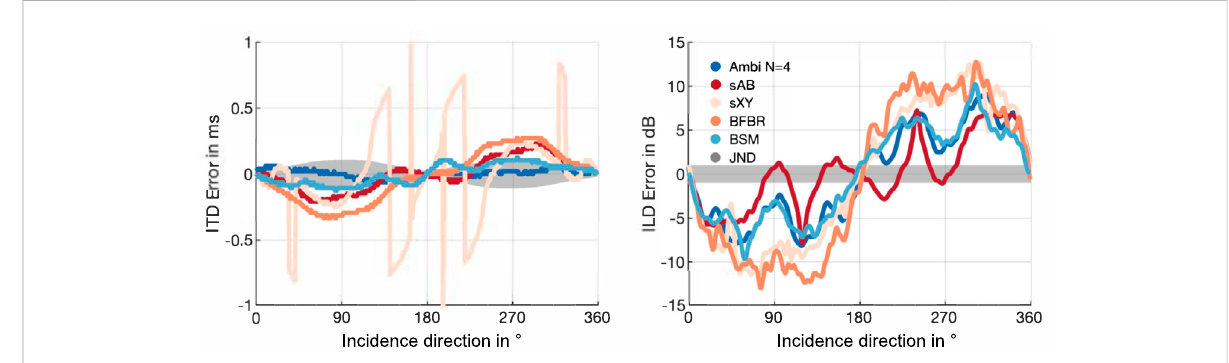
FIGURE 5 ITD and ILD errors of the EMA6 array using different binaural reproduction approaches. The shaded gray areas represent JNDs.